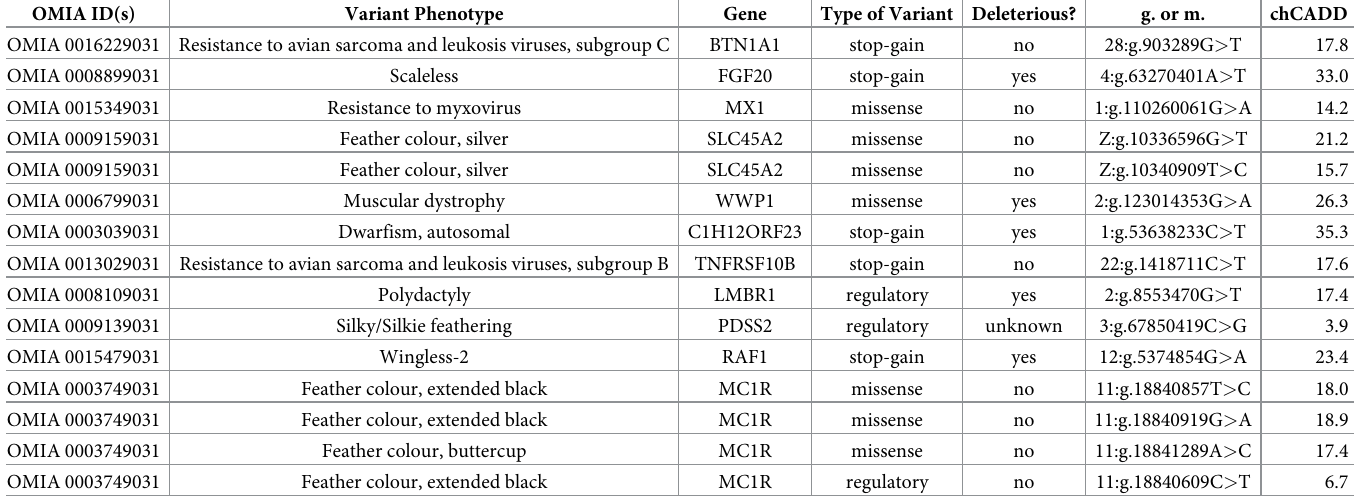
Table 3. Annotation of known causative variants with the chCADD score. SNPs were obtained from the Online Mendelian Inheritance in Animals (OMIA) and their genomic position was lifted over to the GRCg6a reference genome. OMIA ID(s) Variant Phenotype Gene Type of Variant Deleterious? g. or m. chCADD